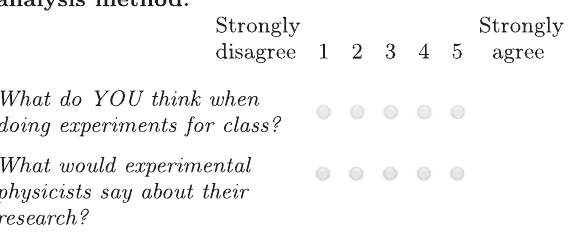
FIG. 1. An example item from the E-CLASS. Students are asked to rate their agreement with the statement from their own perspective and that of an experimental physicist. See Fig. 2 or Ref. [24] for a list of all item